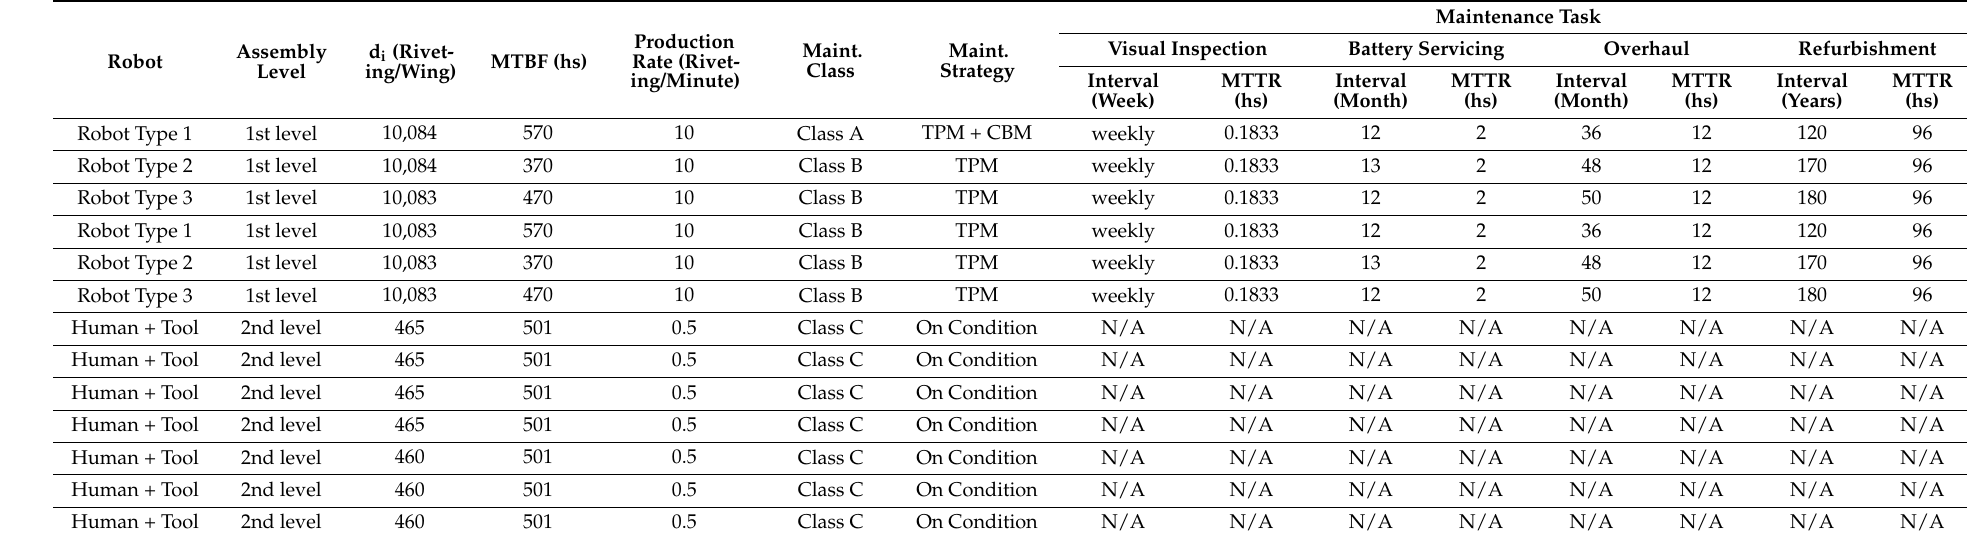
Table A2. Assembly Line Model